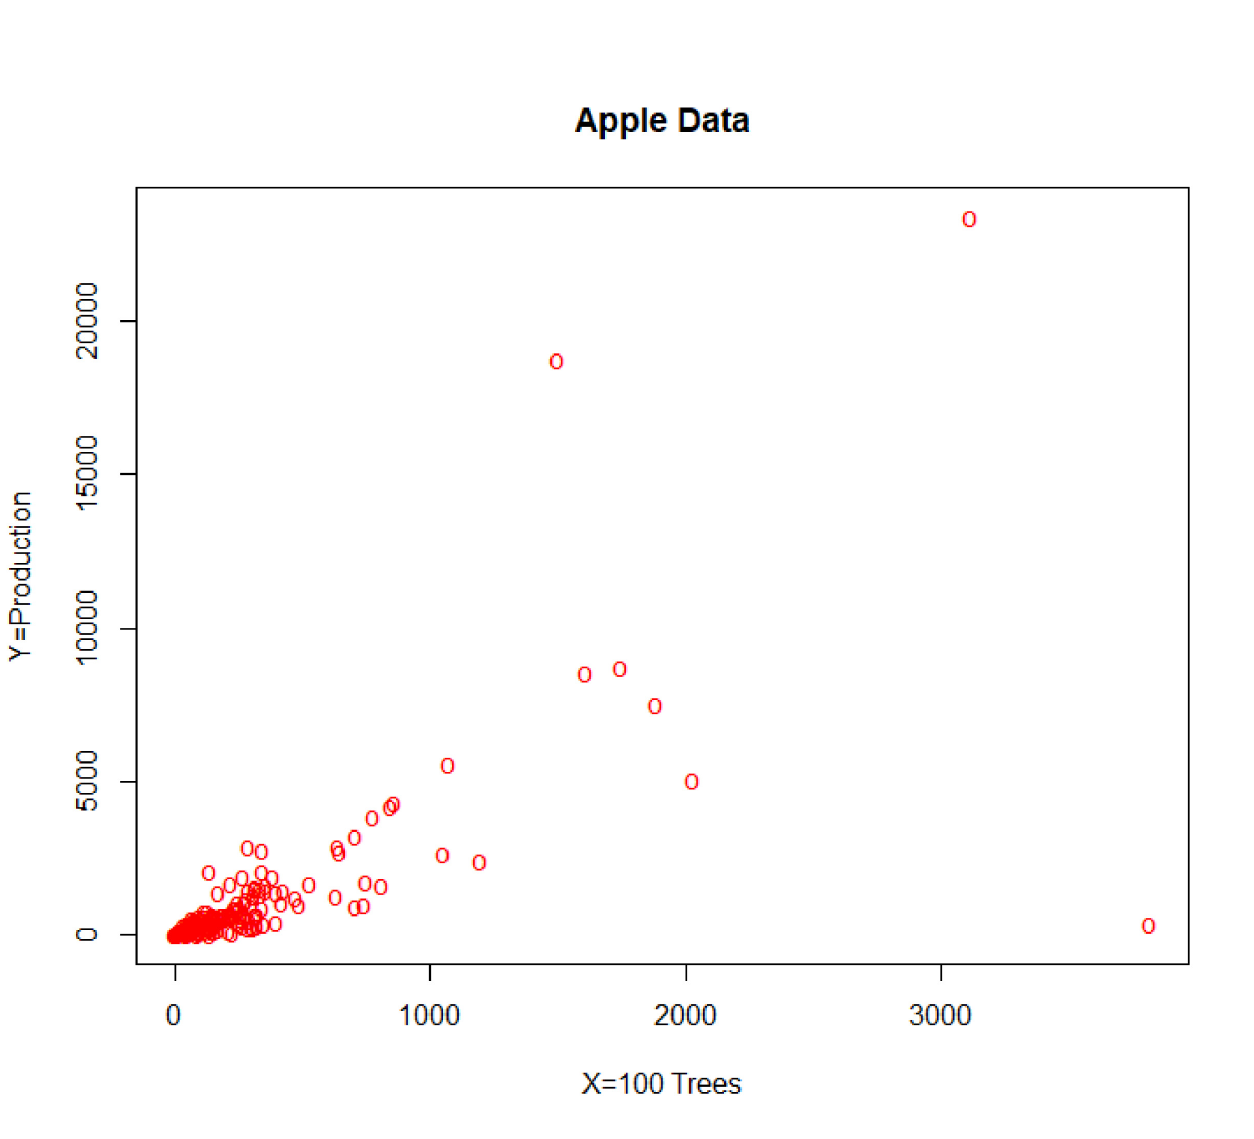
Fig 2. Scatter plot of apple dataset.